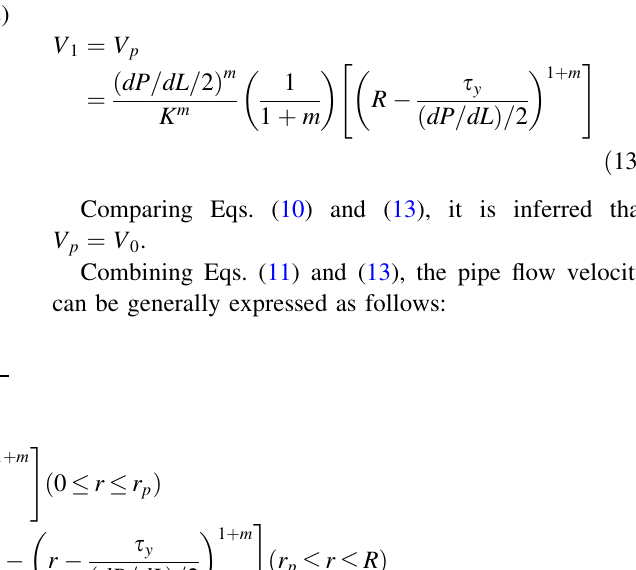
Fig. 1 A schematic of the HB laminar fluid flow through the